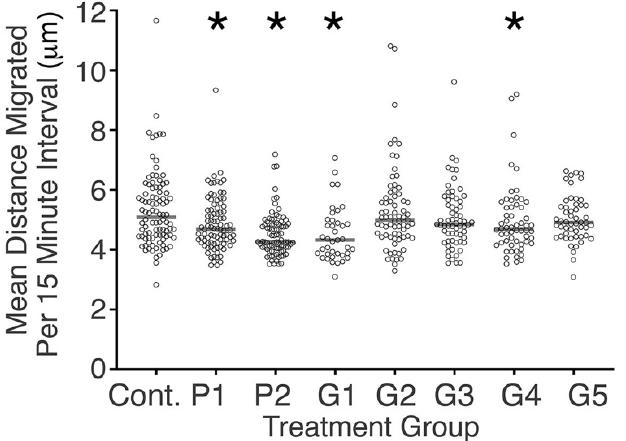
Figure 2. Scattergram showing the mean distance that each tracked cell migrated in intervals of 15 min. Median values for each condition studied are shown as horizontal lines. Significant differences in migration rate were observed between cells of some conditioned media and control cells (* p < 0.05, Mann–Whitney U test).